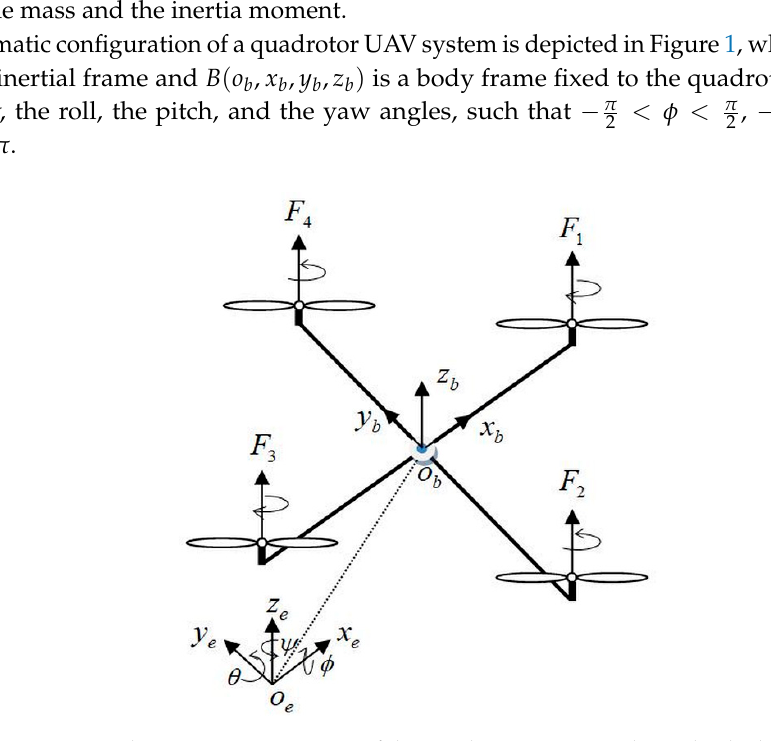
< φ < π < θ < π , − π , and 2 2 2 2